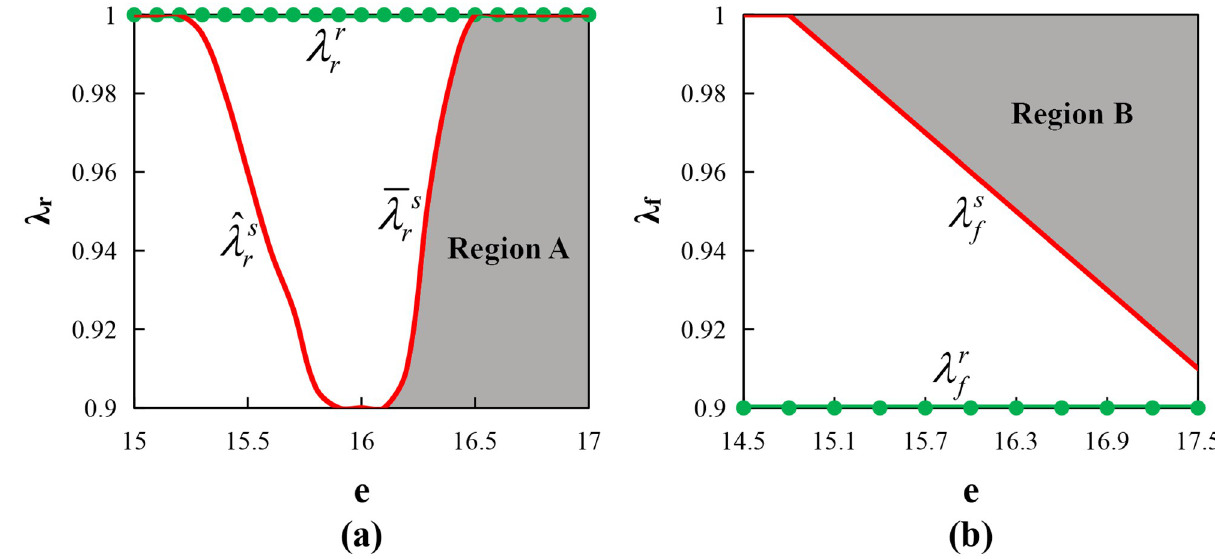
Fig 2. Impact of risk aversion on the Pareto